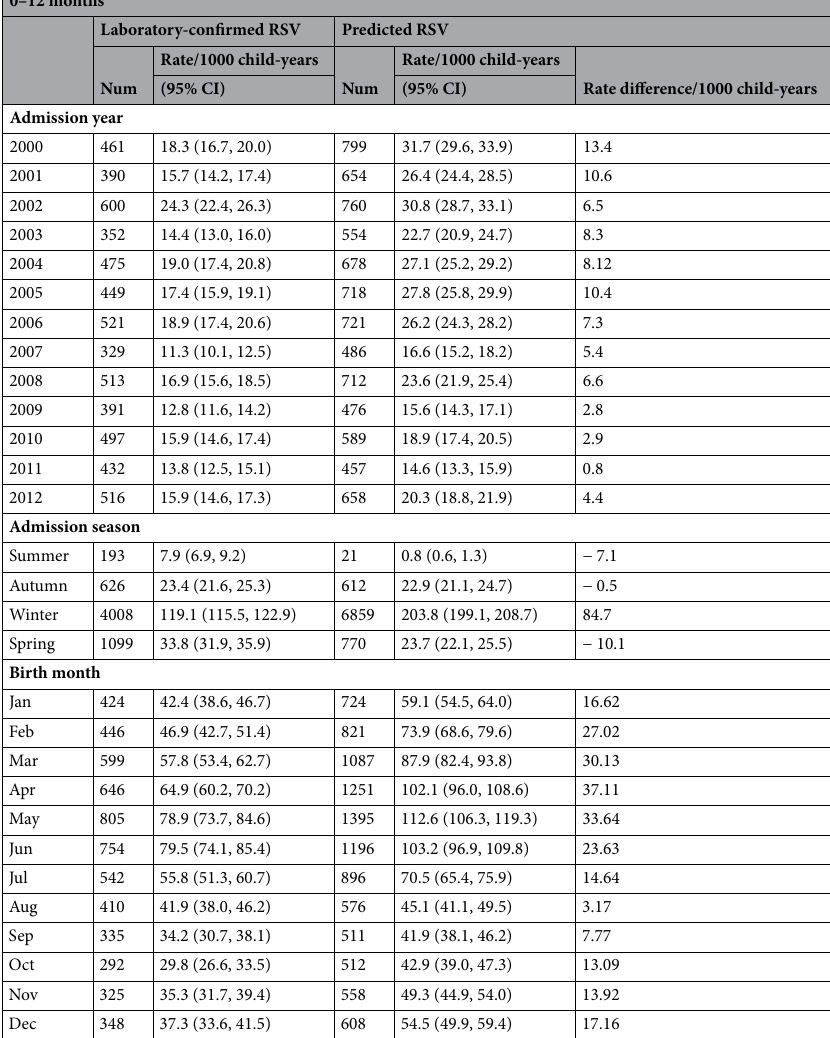
Table 3. Incidence rates of laboratory-confirmed and predicted RSV positivity by selected patient characteristics among children aged < 12 months,